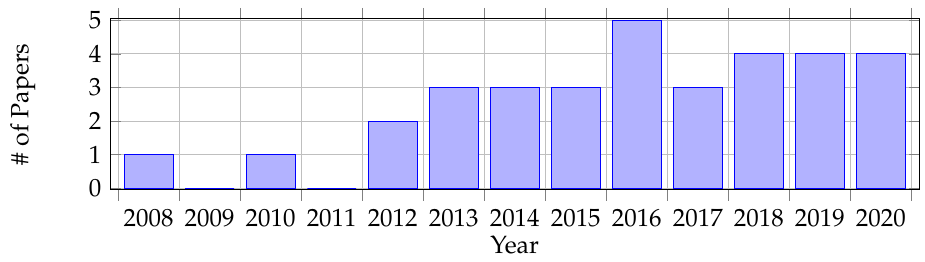
Figure 2. The number papers related to touchscreen-based image accessibility.